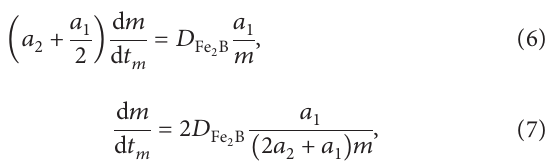
Figure 1: Boron concentration profile: (a) schematic of boron concentration distribution in the Fe balance equation at the Fe 2 B/substrate